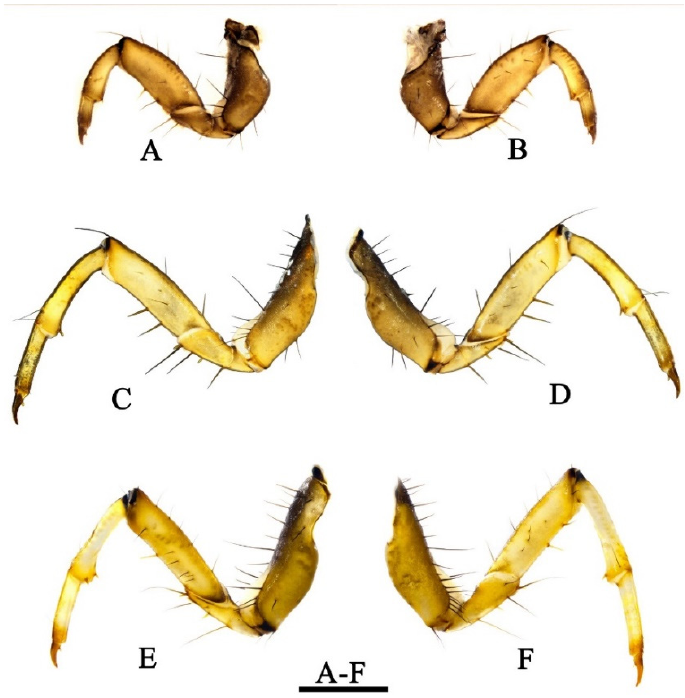
Figure 10. Limnephilus deqianensis n. sp. , larva legs. ( A ) Left foreleg posterior side; ( B ) left foreleg anterior side; ( C ) left midleg posterior side; ( D ) left midleg anterior side; ( E ) right hind leg anterior side; ( F ) right hind leg posterior side. Scale bar: 1 mm.